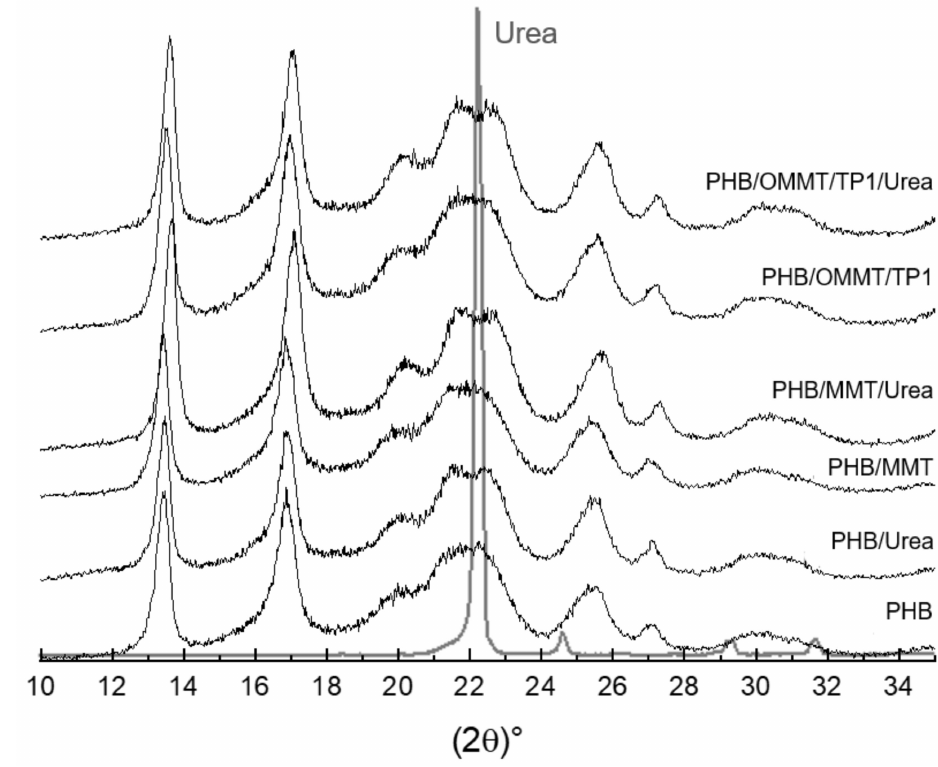
Figure 4. XRD patterns of microcapsules empty and with urea and urea. Table 1. Thermogravimetric analysis (TG) results of